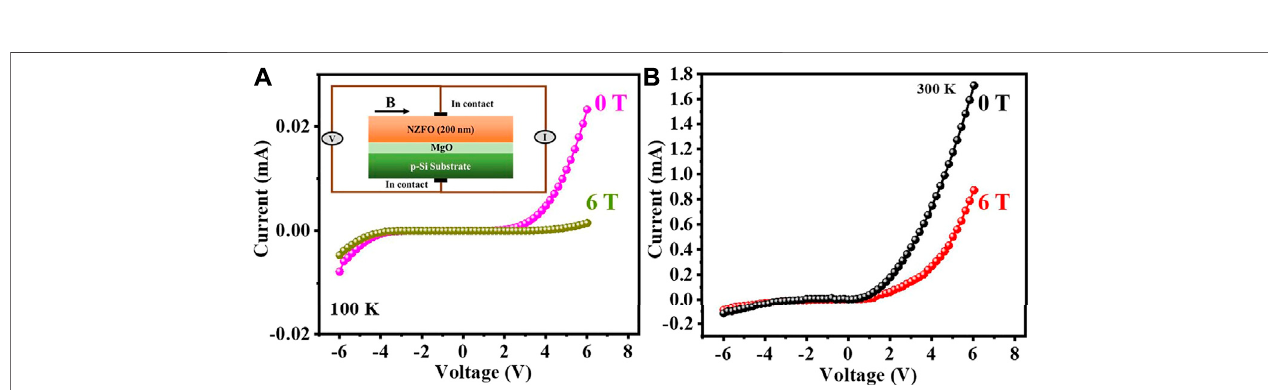
FIGURE 8 | (A) Fowler – Nordheim plots of the NZFO/MgO/p-Si heterostructure at B (cid:1) 0 T. (B) Poole – Frenkel plots for the same heterostructure in the absence of magnetic fi eld.